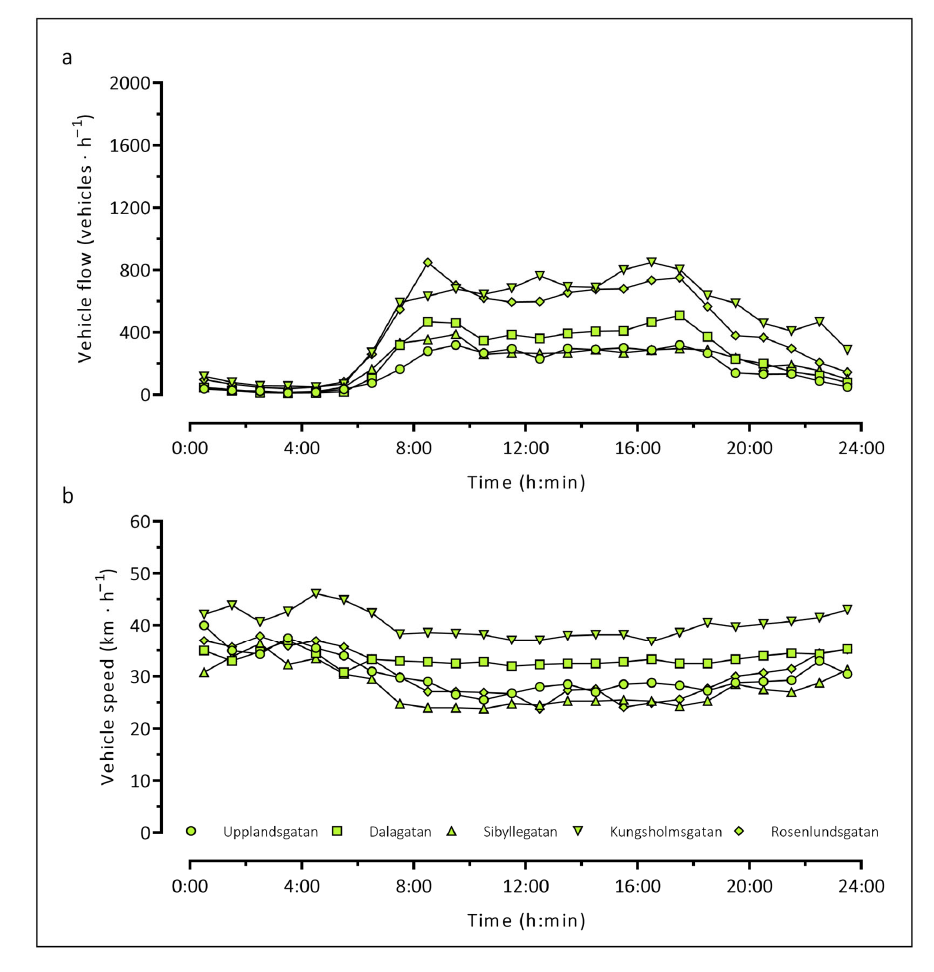
Figure A1. Vehicle flow ( a ) and average vehicle speed ( b ) per hour on local streets and collector roads in inner urban areas of Stockholm. The measurement points show data for both driving di ‐ rections during a typical weekday (Monday or Wednesday) in April 2005. The ratio between light motor vehicles ( ≤ 3500 kg) and heavy (>3500 kg) was: 94.6%. Data has been collected by the City of Stockholm Transport Department (in Swedish: Trafikkontoret, Stockholms stad). Further infor ‐ mation about these traffic measurements can be found in the City of Stockholm report [46].